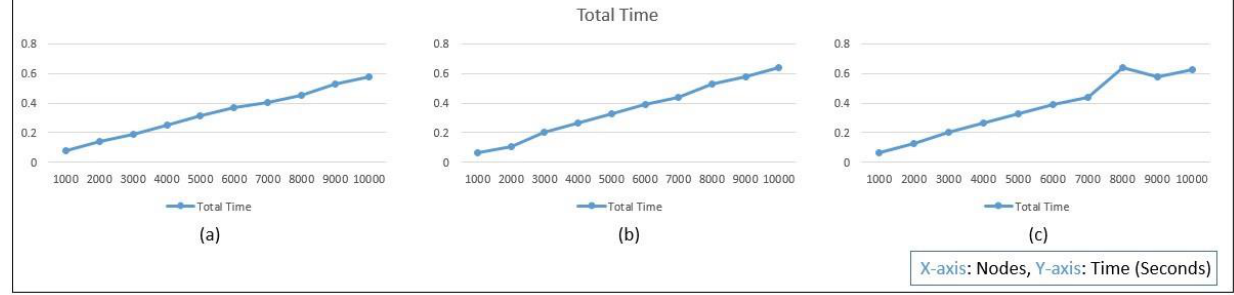
Figure 6. Total time analysis for the LCG: ( a ) GCC, ( b ) Borland, and ( c ) Turbo.